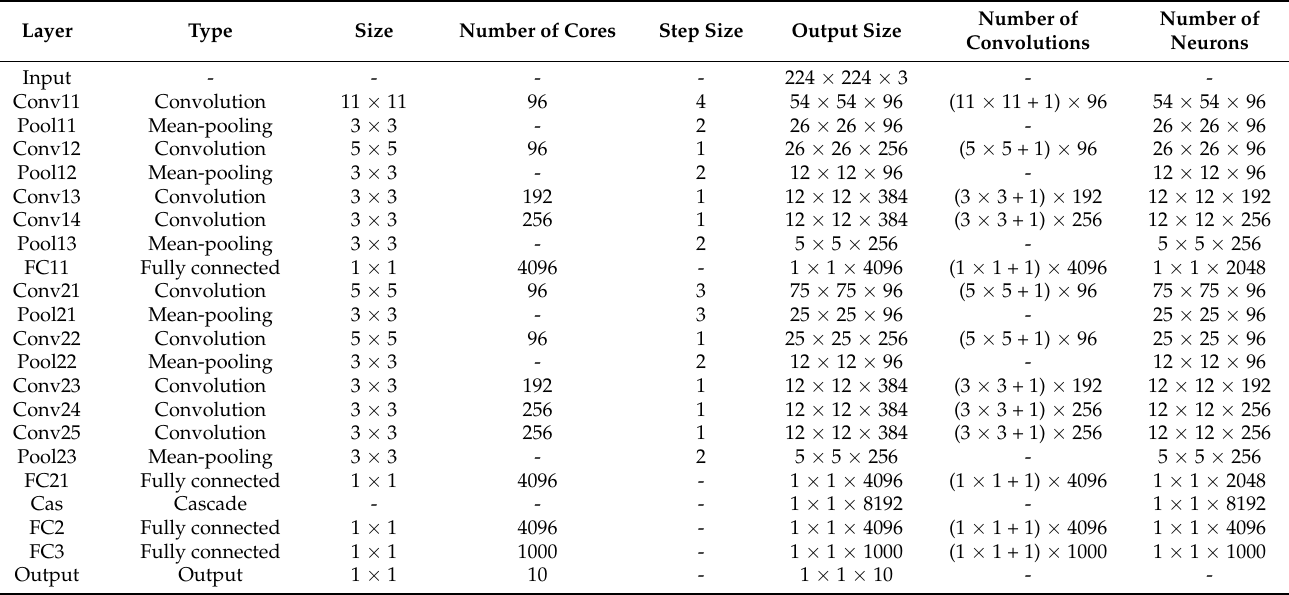
Table 1. Details of GL-CNN hidden layer parameters.